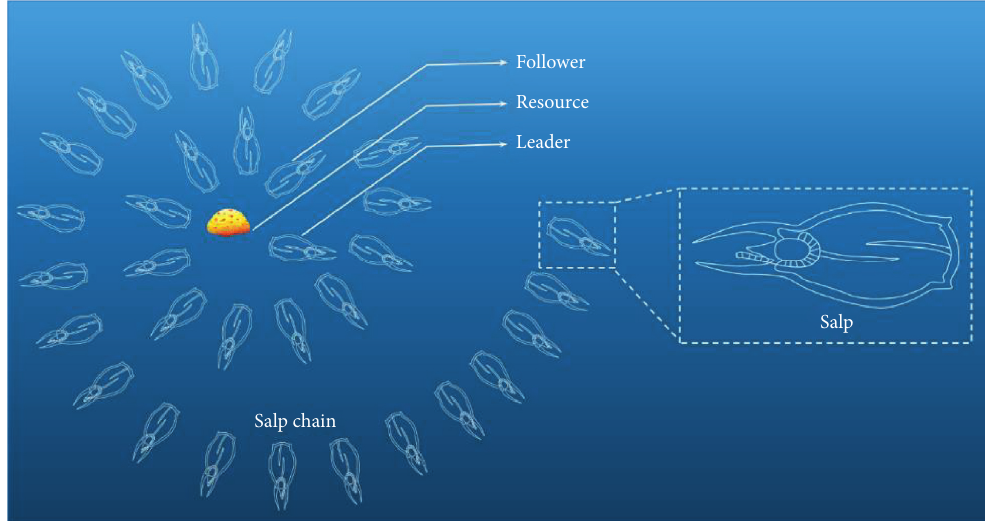
Figure 2: Swarm behavior of the slaps in the deep ocean (picture of the salp modified from